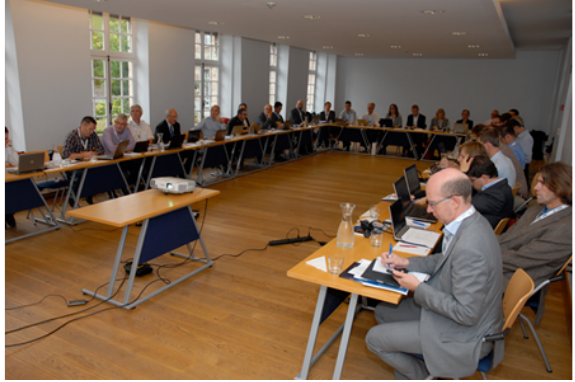
Figure 1. Board of Delegates meeting (Leuven, 2014).